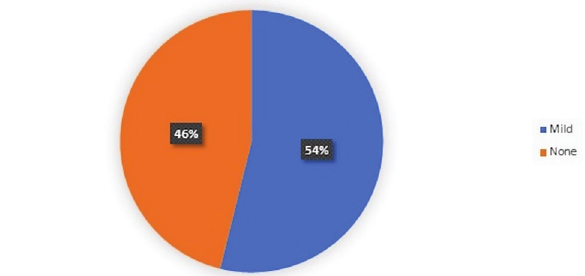
Figure 5 - Distribution of patients in terms of atherosclerosis